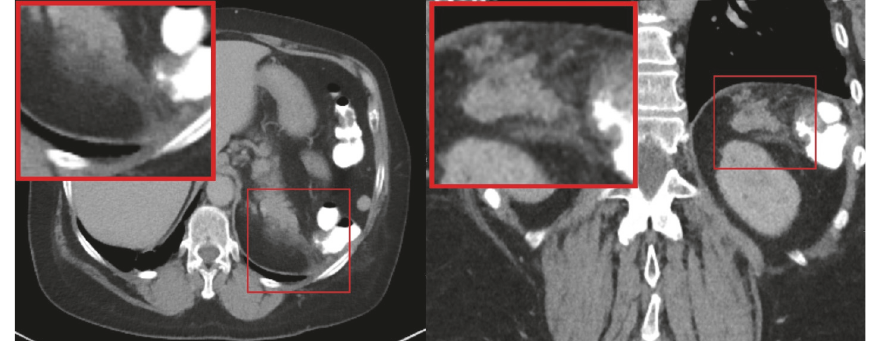
Figure 1: Computed tomography of the abdomen with intravenous and oral contrast. Axial and coronal images demonstrate ill-defined linear increased attenuation adjacent to the tail of the pancreas, representing inflammatory edema in the peripancreatic